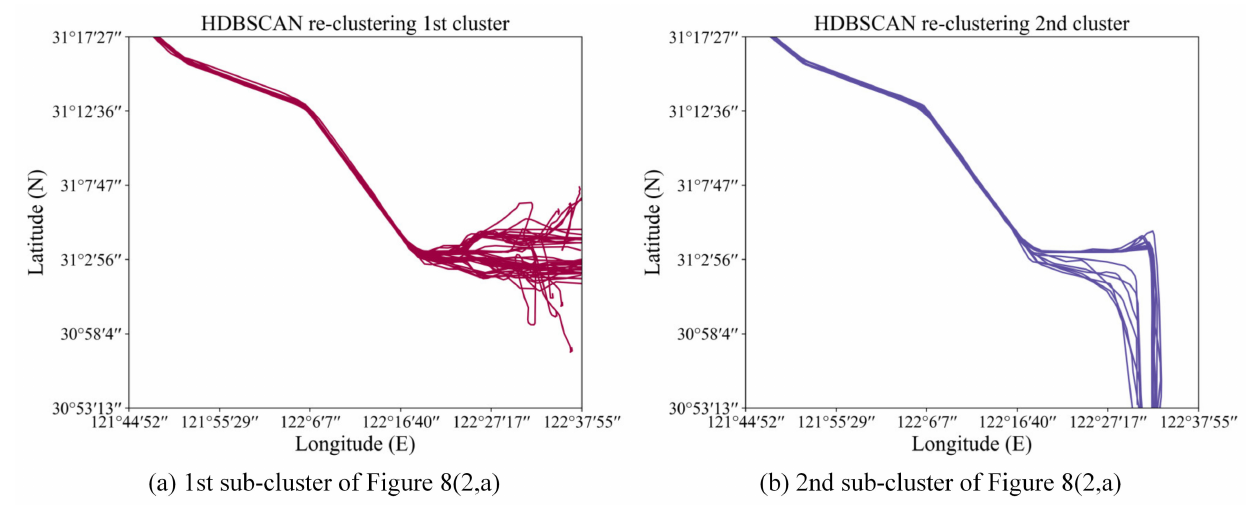
Figure 13. Results of Re-clustering of Figure 8(2a) based on HDBSCAN.